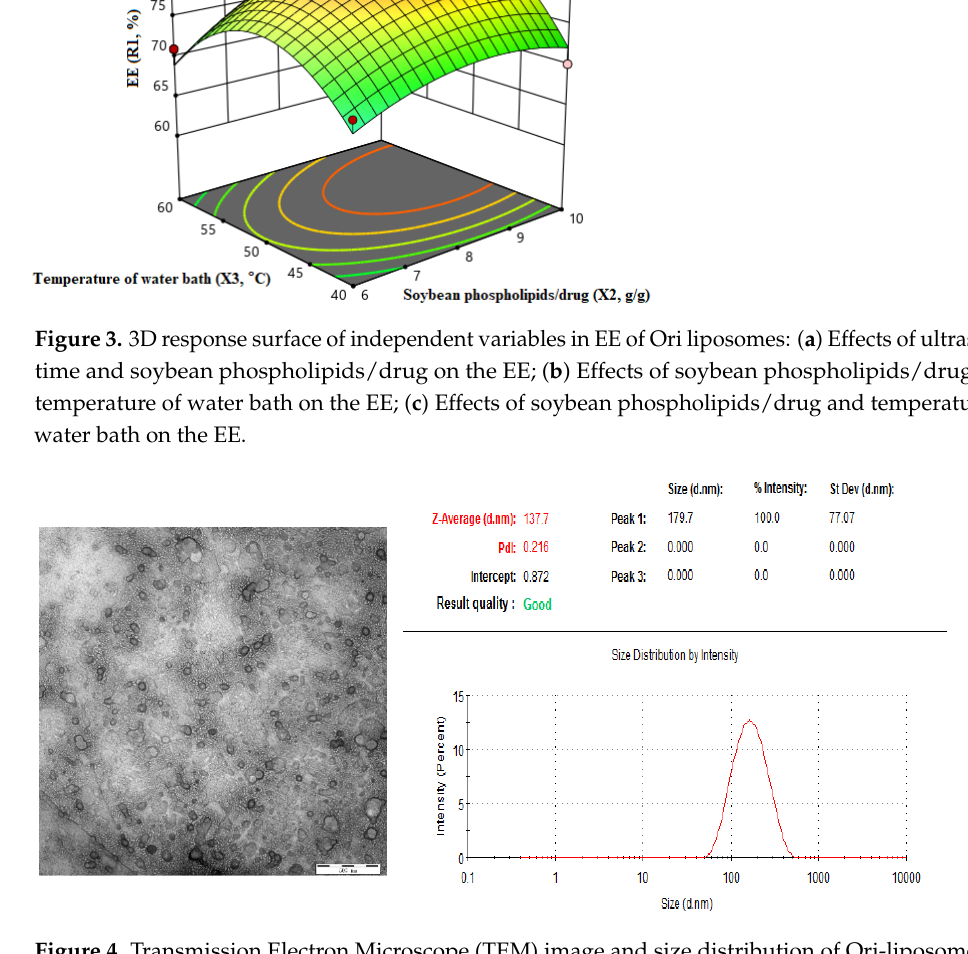
Figure 4. Transmission Electron Microscope (TEM) image and size distribution of Ori-liposomes.